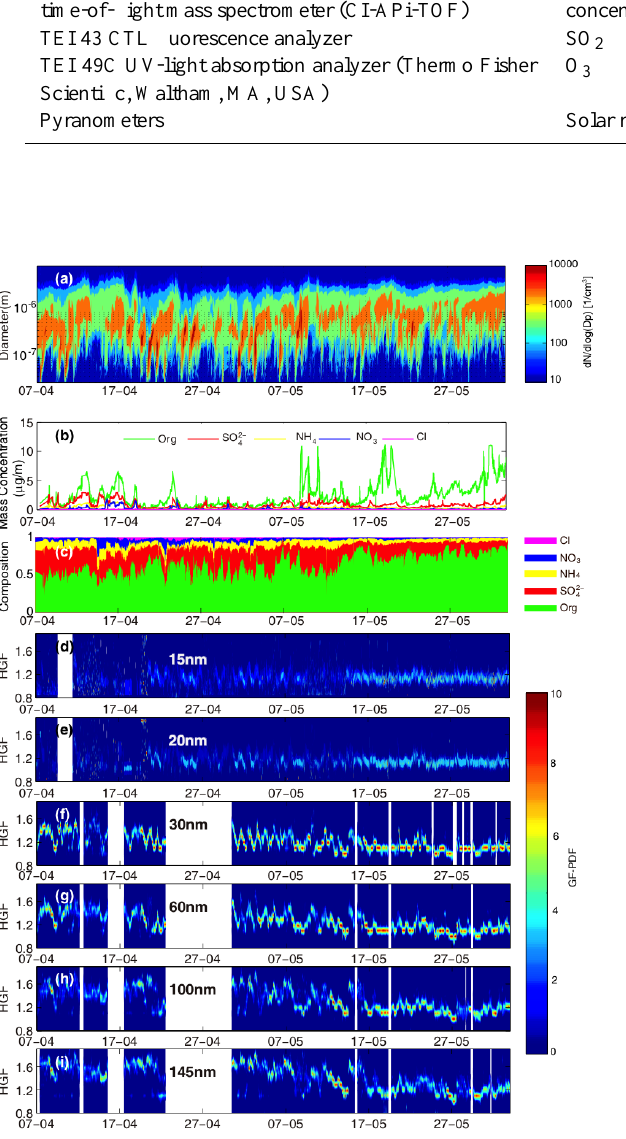
Figure 1. (a) Time series of particle number size distribution using DMPS. (b–c) Time series of mass concentrations and mass frac- tions of chemical species (sulfate, nitrate, ammonium and organ- ics) in submicron particles from HR-AMS. (d–i) Time evolution of hygroscopic growth factor distribution for 15, 20, 30, 60, 100 and 145nm particles using HTDMA.